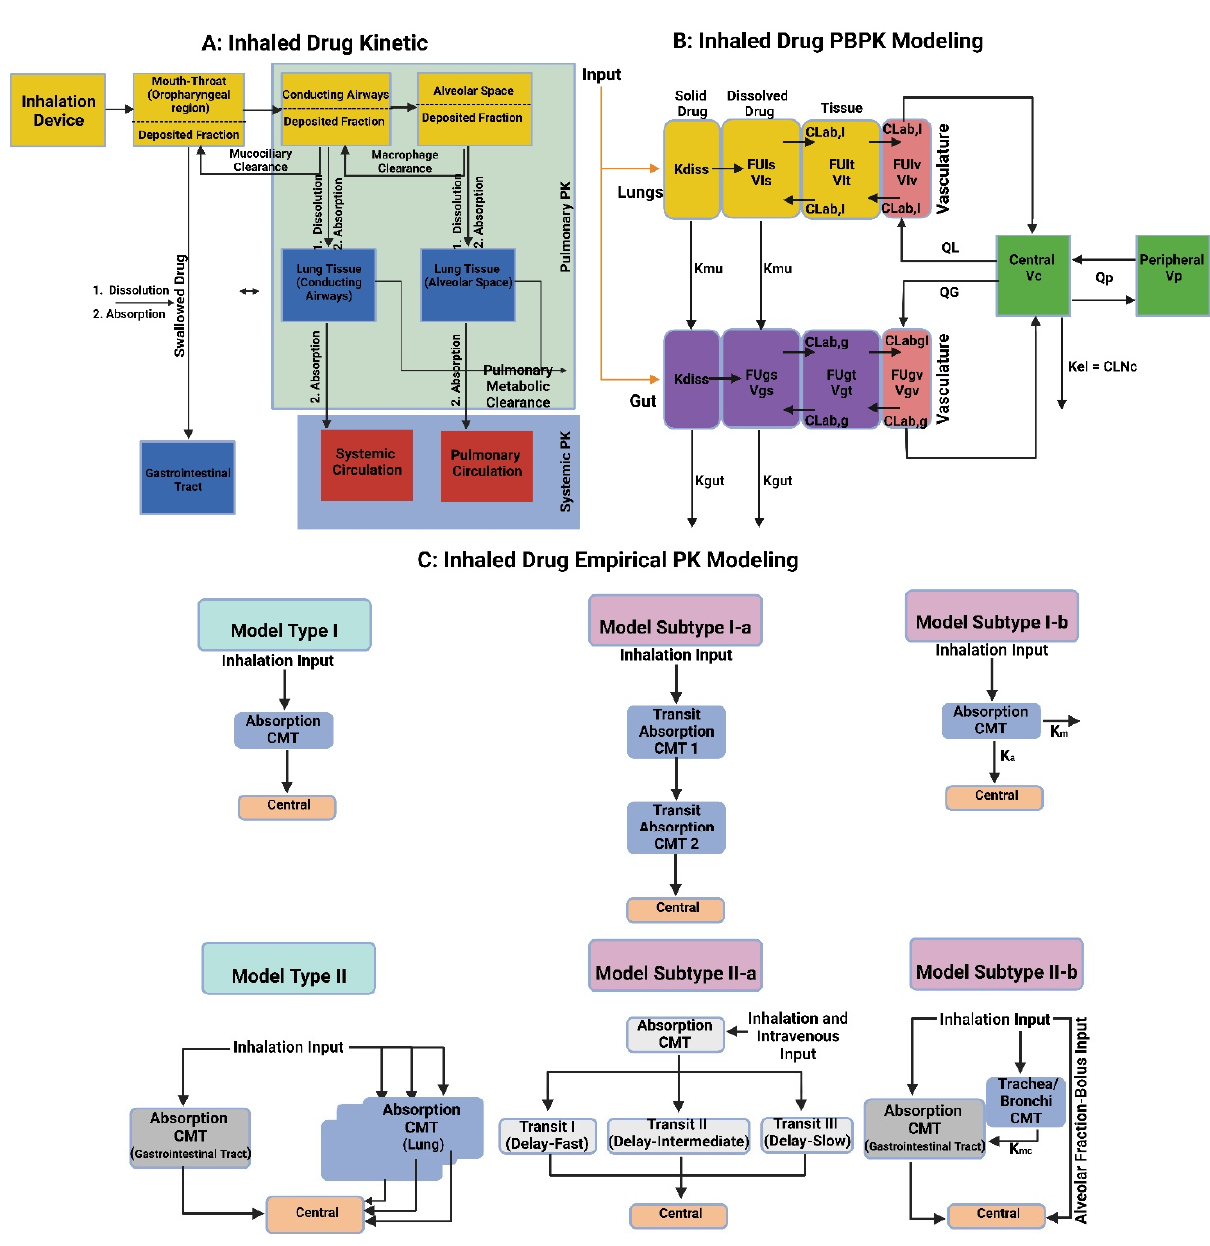
Figure 12. Schematic representation: ( A ) Inhaled Drug Kinetic. ( B ) Inhaled Drug PBPK Modeling. ( C ) Inhaled Drug Empirical PK Modeling.